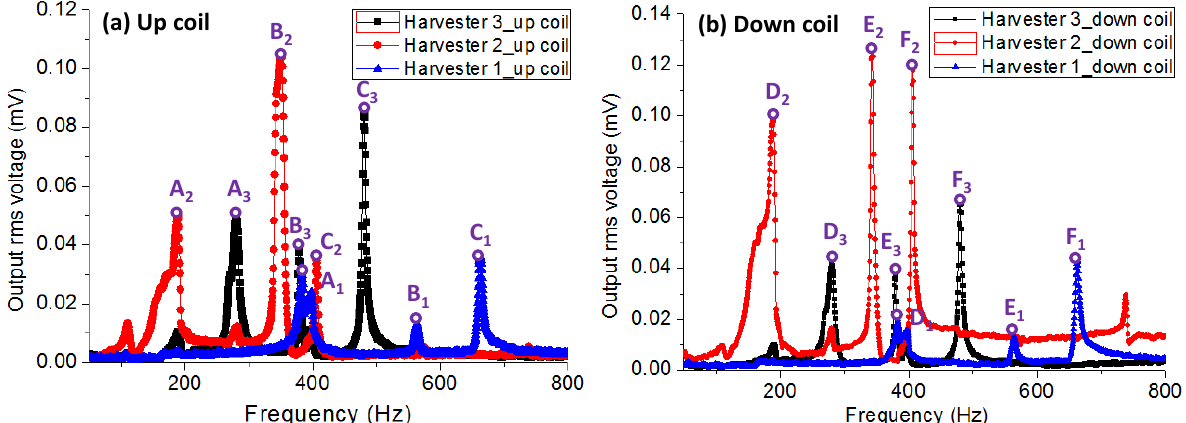
Figure 3. ( a ) A closed-loop vibration control system with assembled EH array device; ( b ) the scanning electron microscope (SEM) image of the enlarge spring.